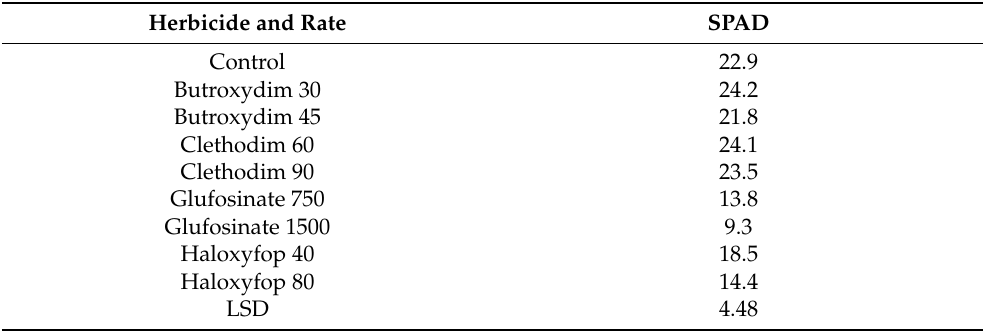
Table 4. The effect of herbicide treatment on chlorophyll content (Soil Plant Analysis Development; SPAD) of Chloris virgata